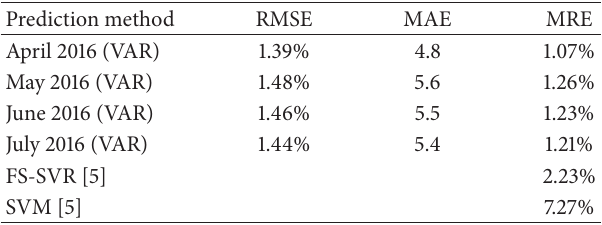
Table 5: Comparison